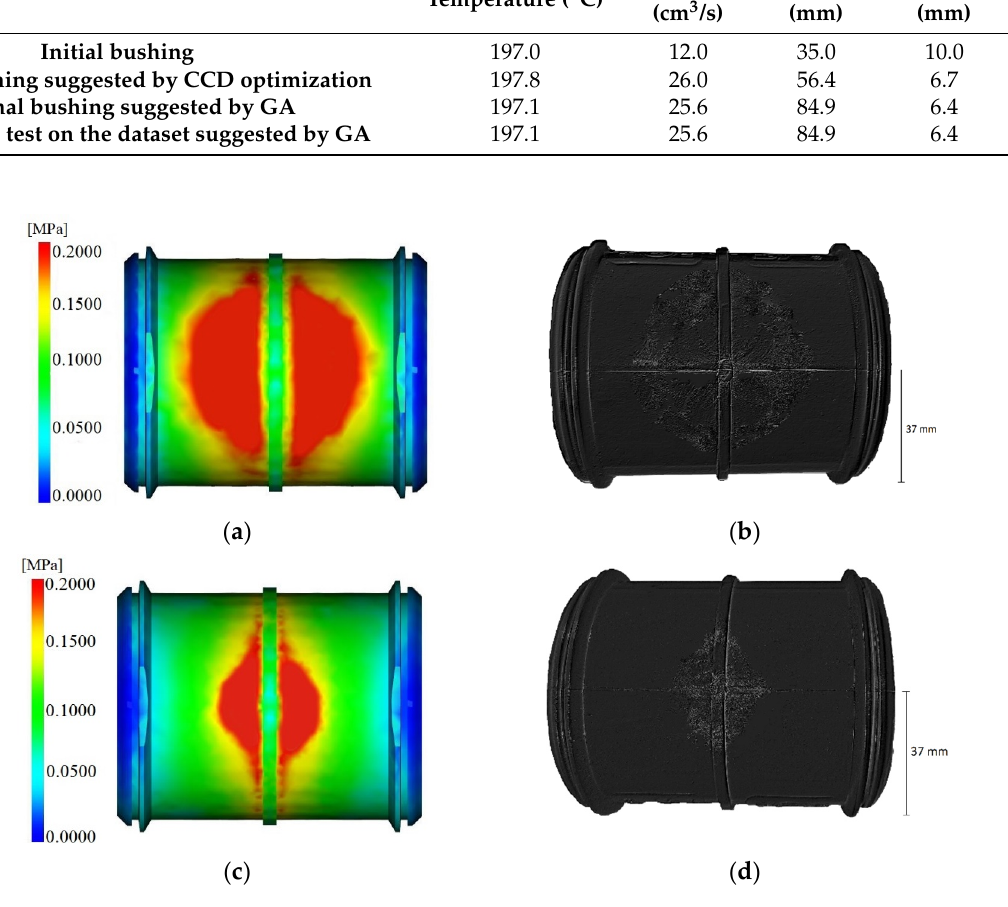
Figure 13. The initial defected bushing area is in simulation ( a ) and experimental test ( b ); and the bushing is after optimization in simulation ( c ) and experimental test ( d ).